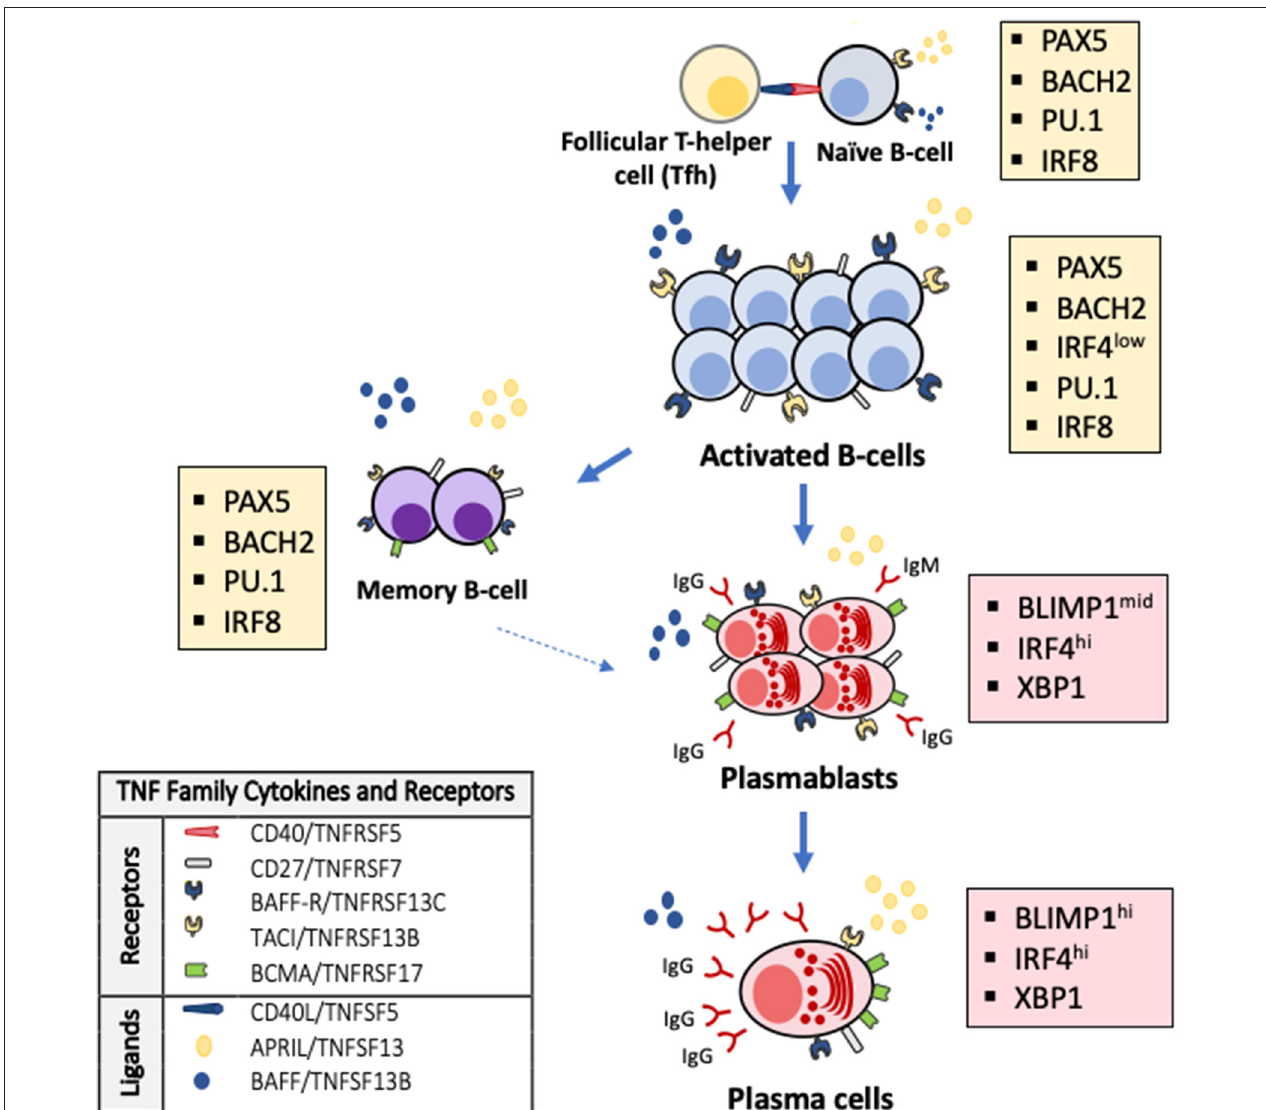
FIGURE 1 | TNF superfamily signaling and transcriptional changes regulate terminal B-cell maturation and antibody production. Activated B-cells undergo apoptosis as default fate unless survival signals are delivered by the TNF superfamily cytokines BAFF (B-cell activation factor, TNFSF13B) and APRIL (a proliferation inducing ligand, TNFSF13) through their receptors TACI (transmembrane activator and calcium modulator and cyclophilin ligand interactor, TNFRSF13B) and BAFF-R (B-cell activating receptor, TNFRSF13C) on the surface of B-cells and BCMA (B-cell maturation antigen, TNFRSF17) on the surface of antibody secreting cells and some memory B-cells. Antibodies are exclusively secreted by ASC that arise from B-cells after profound changes in their transcriptional program (colored boxes). The generation of ASC requires that PAX5 and the transcriptional program that maintains B-cell identity (e.g., IRF8, PU.1, BACH2) are silenced and BLIMP-1, the master regulator of ASC differentiation and associated factors (e.g., XBP1, IRF4) are